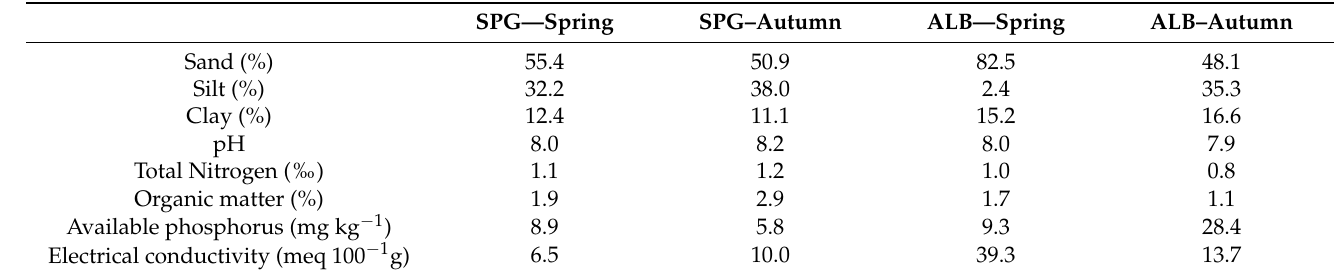
Table 1. Physical and chemical characteristics of the soil at the experimental sites (0–0.3